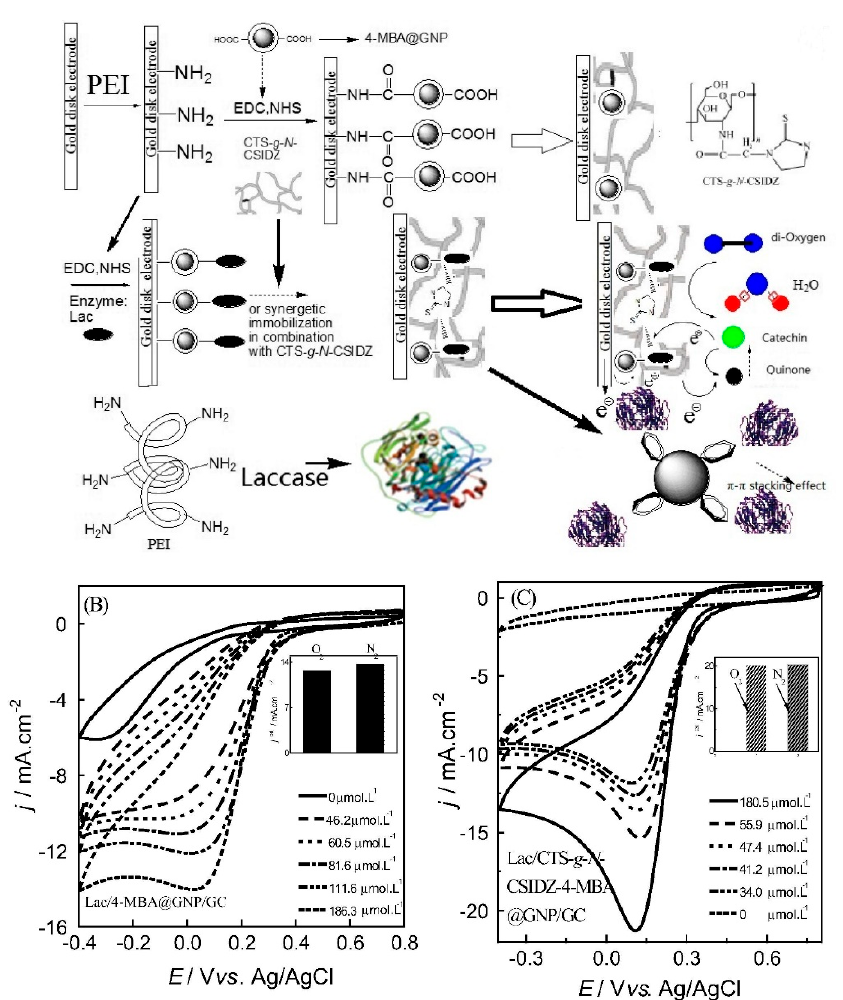
Figure 9. Illustrations for preparation process of Lac / CTS-g-N-CSIDZ-4-MBA@GNP / GD and its catalytic reactions on the surface of electrode. Reprinted from ref. [91] with permission of Elsevier.